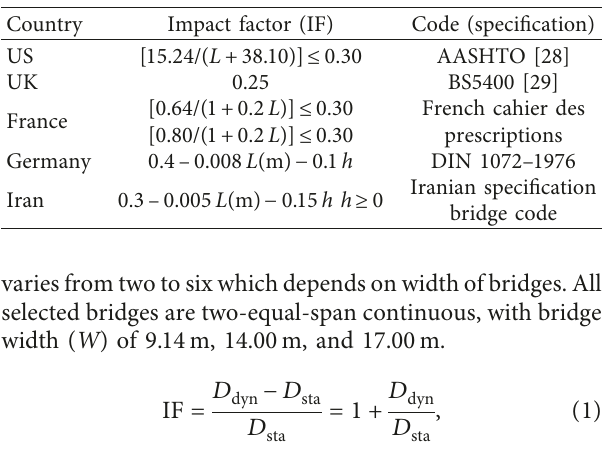
Table 1: Impact factors specified by various